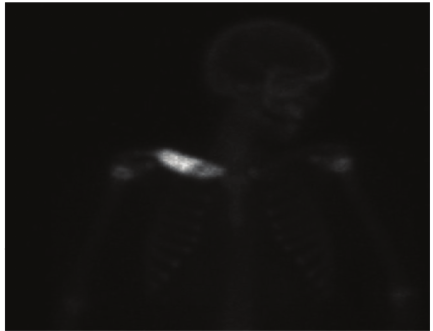
Figure 4: A distinctive hot spot of the right